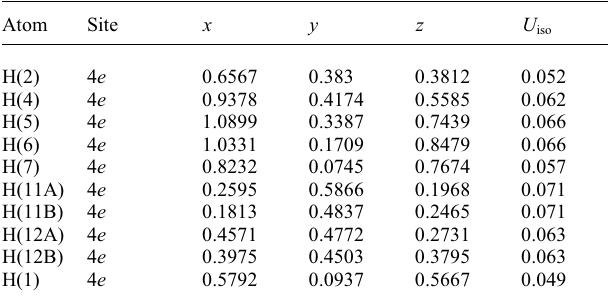
Table 2. Atomic coordinates and displacement parameters (in Å 2 )